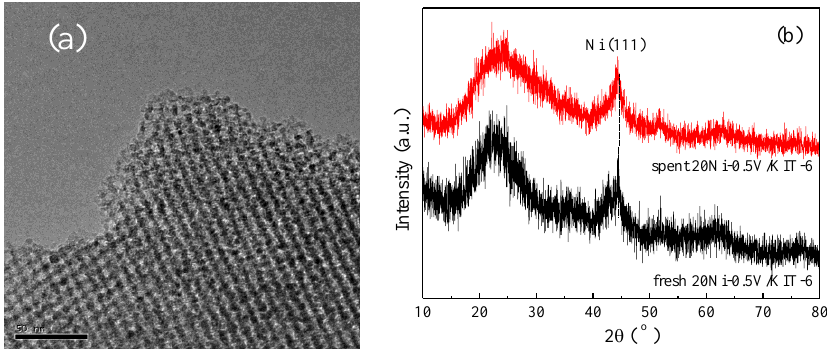
Figure 9. ( a ) TEM images of spent 20Ni-0.5V / KIT-6; ( b ) XRD profiles of fresh and spent 20Ni-0.5V / KIT-6.